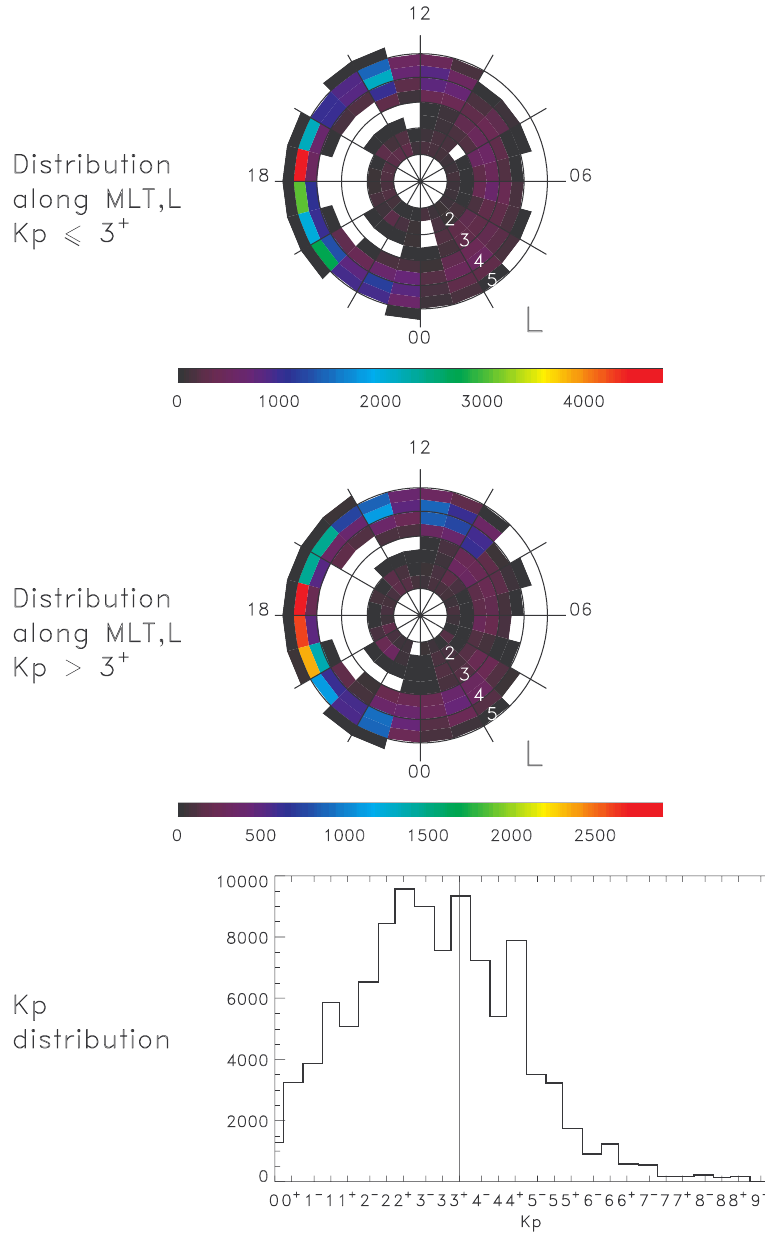
Fig. 1. From top to bottom: Distribution of measurements as a function of MLT for low (top panel) and high (middle panel) magnetic activity, and distribution of the K p index during the analyzed period (bottom